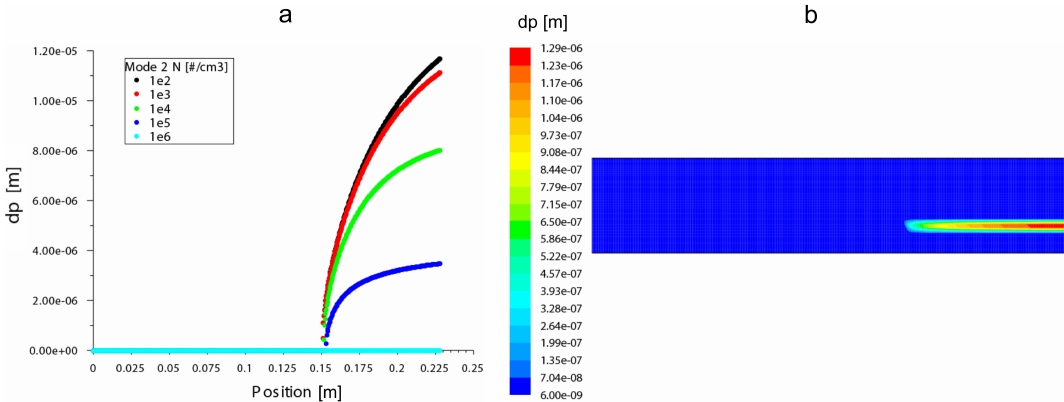
Fig. 6. Mode 2 ( d p, 2 =15nm) axial particle diameter profiles for a bimodal particle size distribution ( a , T s =293.15K, T gt =333.15K, d p, 1 =6nm, c n, 1 =10 4 #/cm 3 ) , and mode 1 particle diameter distribution ( b , T s =293.15K, T gt =333.15K, d p, 1 =6nm, c n, 1 =10 3 #/cm3, d p, 2 =15nm, c n, 2 =10 5 #/cm 3 )